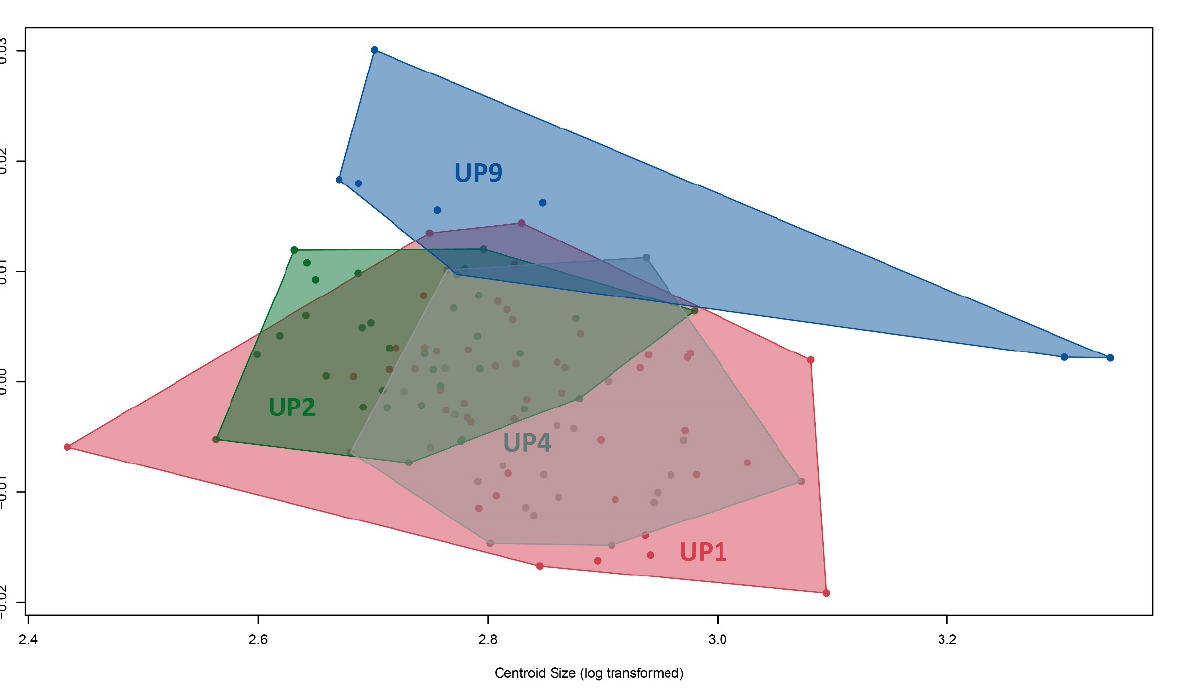
Figure 4. Graphic representation of variation in the mean shape of C. kraussii of the populations and their reference points. Red: UEP1; green: UEP2; grey: UEP4; blue: UEP9.